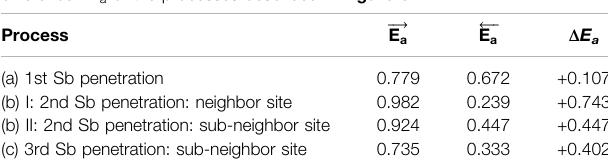
TABLE 1 | Forward energy barrier E a difference Δ E a of the processes described in Figure 8